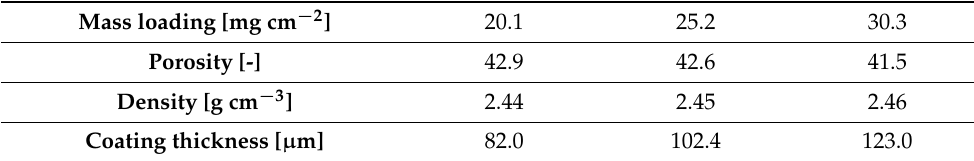
Table 2. Structural parameters of the model